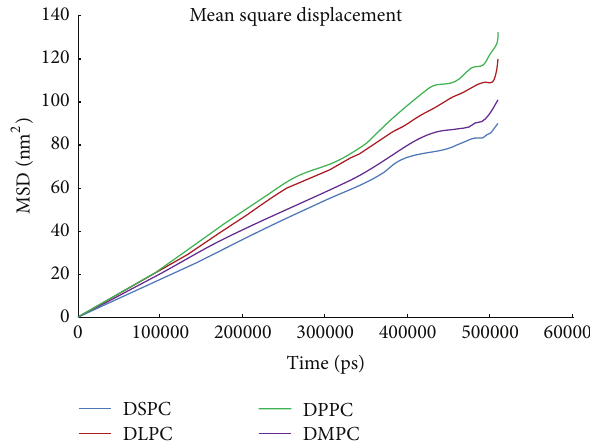
Figure 5: The MSD results of the mixed bilayer system over the time of simulation at 298